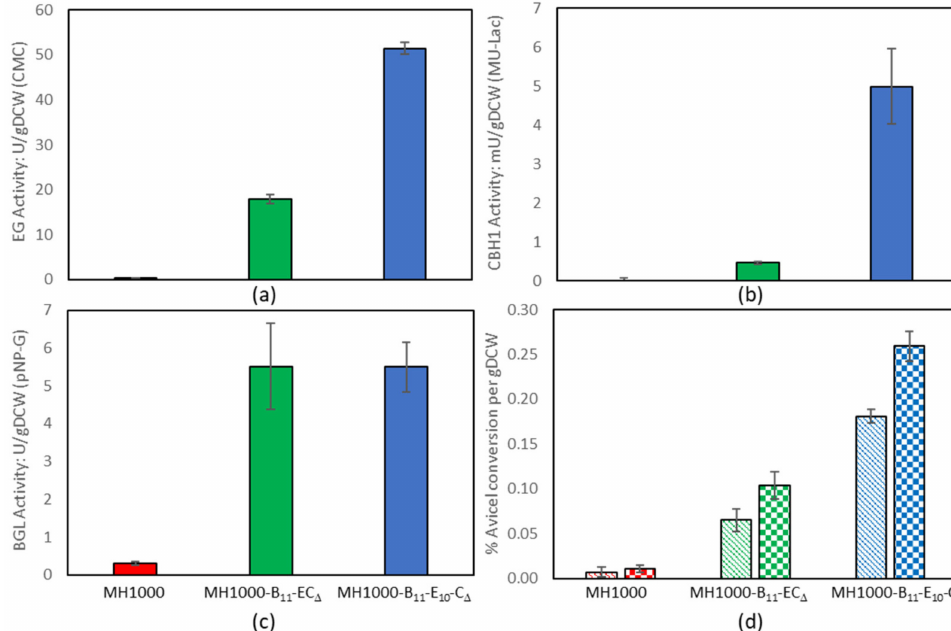
Figure 5. Enzyme activity profiles of recombinant yeast strains after 72 h cultivation. ( a ) The activity of EG2 producing diploid strains on CMC. The untransformed MH1000 strain was used as a negative control. ( b ) Enzyme activity profiles of CBH-producing strains on MU-Lac. ( c ) Enzyme activity profiles of BGL-producing strains on pNP-G. ( d ) Cellulose conversion of the strains measured on Avicel. In ( d ), bars with lines represent values measured after 24 h of the conversion assay, and bars with blocks represent 48-h values. All values obtained were normalized using the dry cell weight (DCW) of each strain at 72 h of incubation. All values represent mean values of assays conducted in triplicate with error bars indicating standard